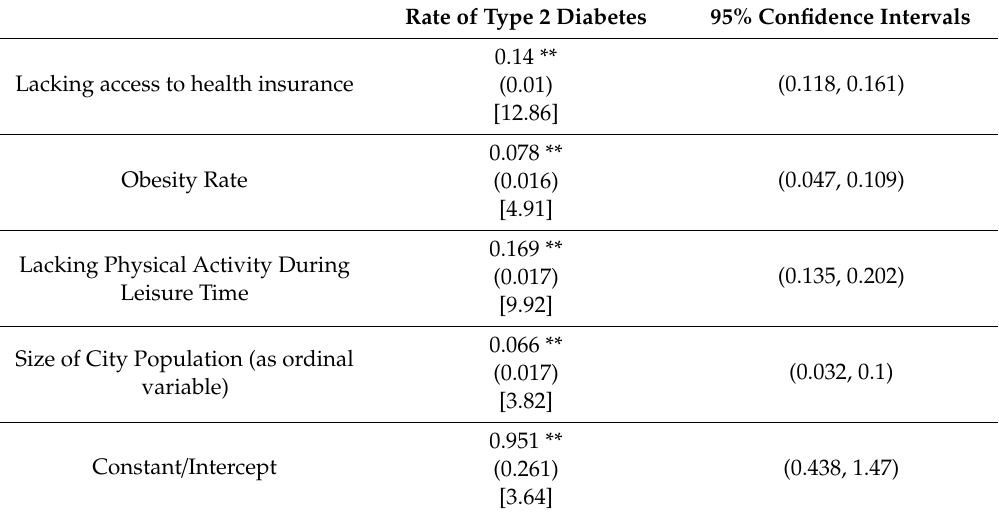
Table 3. E ff ects of insurance access, obesity, sedentary behavior (during leisure time) and size of city population (as ordinal variable) on the rate of type 2